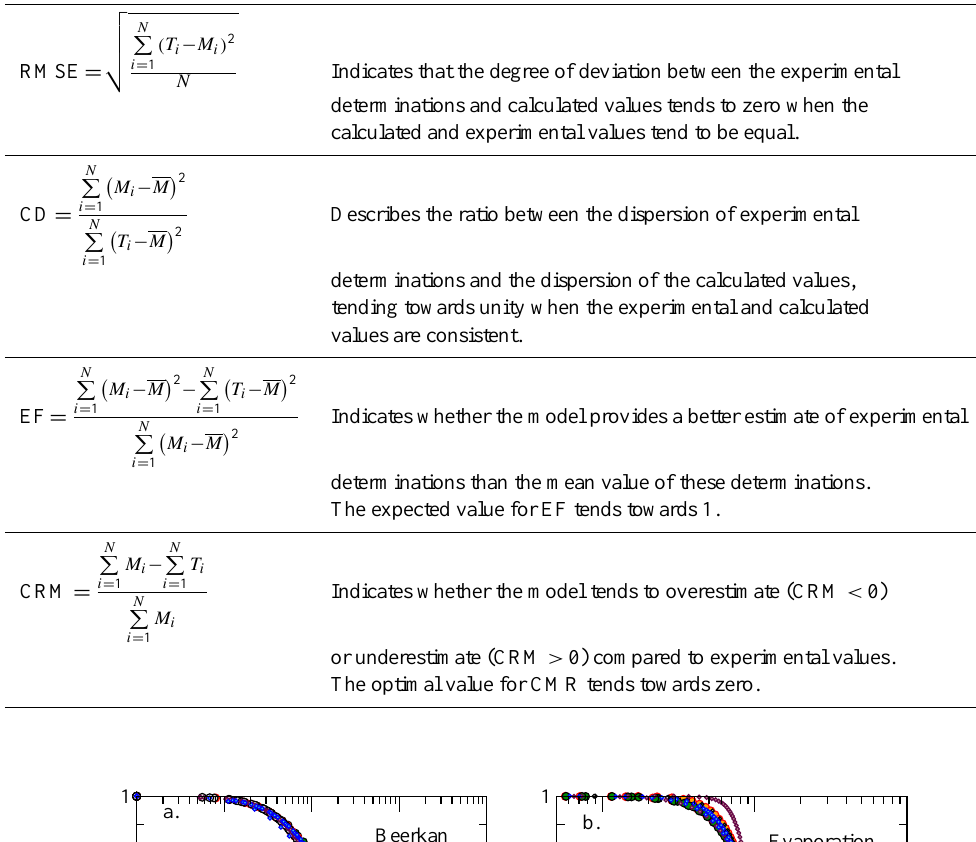
Table 2. Evaluation criteria for performance of modeling.